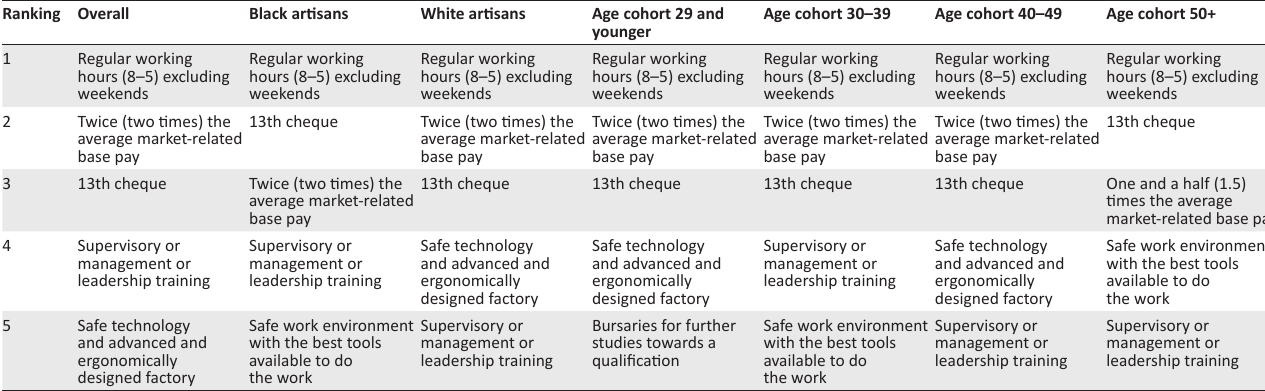
TABLE 12: Ranked levels of reward attributes overall and per demographic group. Ranking Overall Black